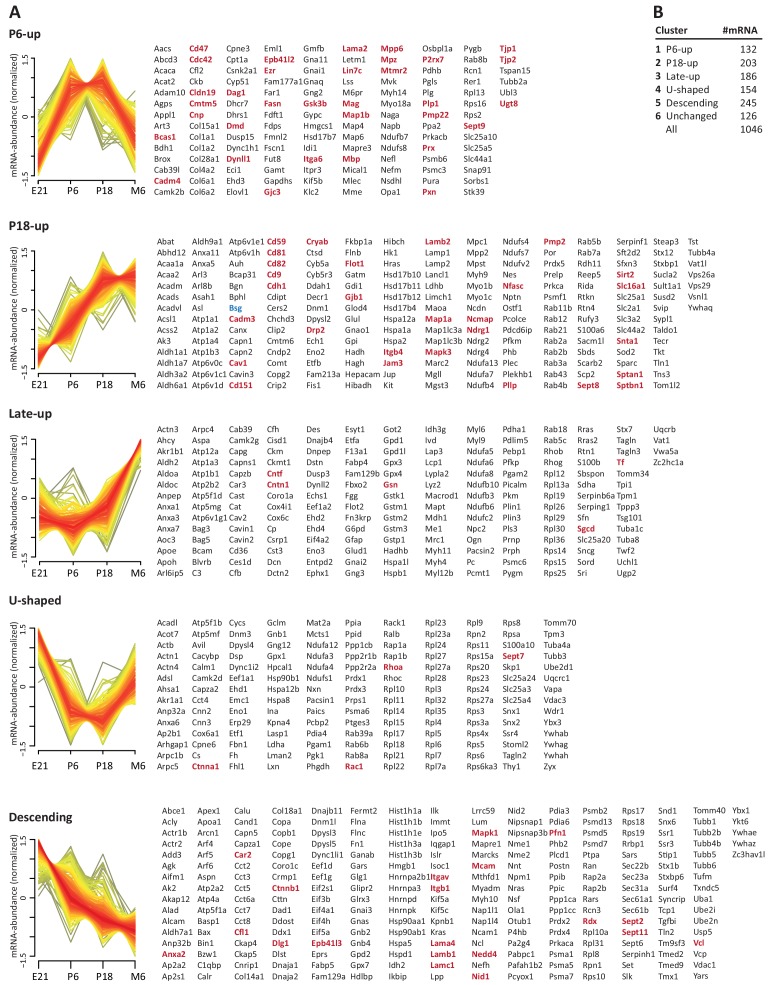
Developmental mRNA abundance profiles of myelin-associated genes.(A) K-means clustering was performed for the mRNA profiles of those 1046 proteins in our myelin proteome inventory for which significant mRNA expression was found by RNA-Seq in the sciatic nerve of rats dissected at ages E21, P6, P18 and 6 months (M6). Note that this filtering strategy allows to selectively display the developmental abundance profiles of those transcripts that encode myelin-associated proteins rather than of all transcripts present in the nerve. Standardized mRNA abundance profiles are shown (n = 4 biological replicates per age). Known myelin genes are displayed in red. For comparison, Pmp22 mRNA was included although the small tetraspan protein PMP22 was not mass spectrometrically identified due to its unfavorable distribution of tryptic cleavage sites. Normalized counts for all mRNAs including those displaying developmentally unchanged abundance are provided in Figure 3—source data 1. (B) Numbers of mRNAs per cluster.Figure 3—source data 1.Normalized developmental mRNA abundance data → sheet 1: normalized values for all individual 4 biological replicates per age → sheet 2: normalized values for biological replicates averaged to give mean per age.